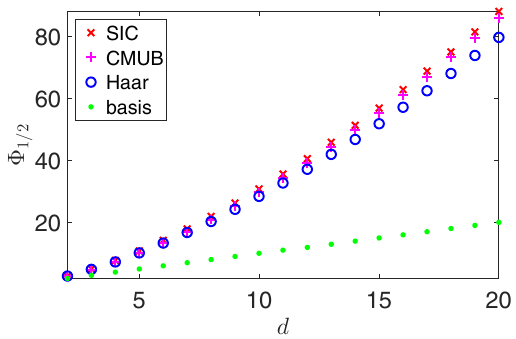
FIG. 1. Frame potentials (cid:8) 1 / 2 of an orthonormal basis, SIC, CMUB, and Haar random pure states, respectively. Here d is the dimension of the underlying Hilbert space H